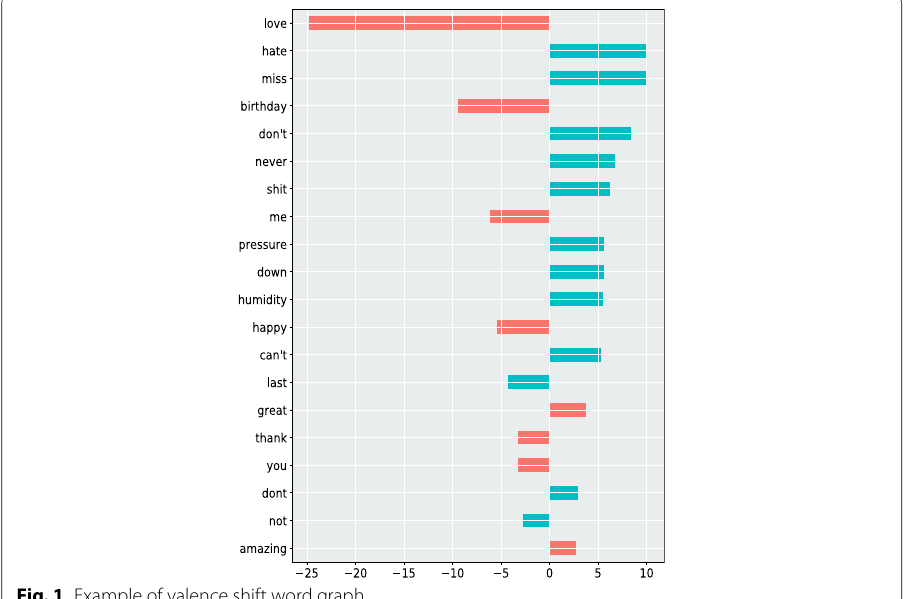
Fig. 1 Example of valence shift word